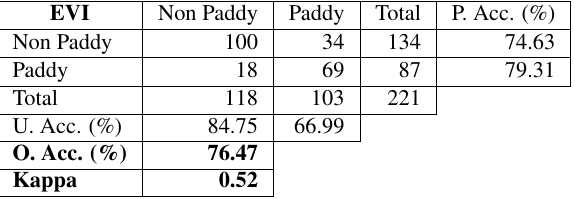
Table 3: Accuracy assessment of EVI-based rice acreage map-